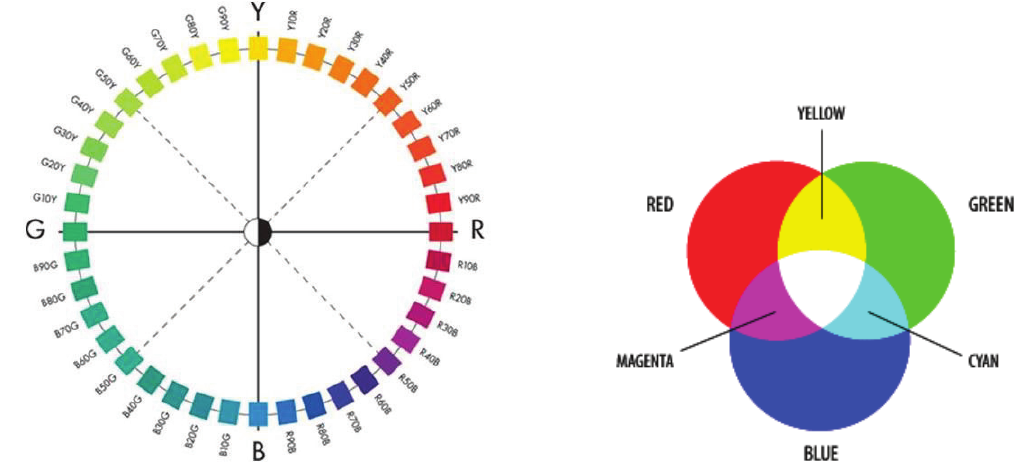
Figure 3. NCS and RGB color models. Left : NCS color model. Right : RGB color